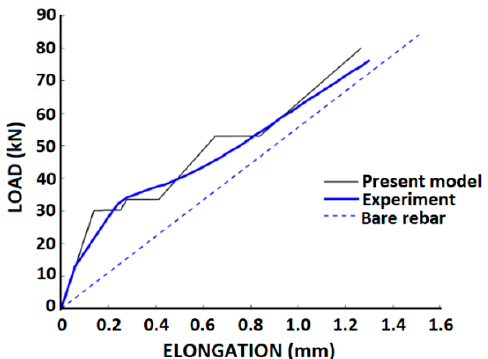
Figure 11. Comparison with Houde and Mirza: axi-symmetrical URCE.